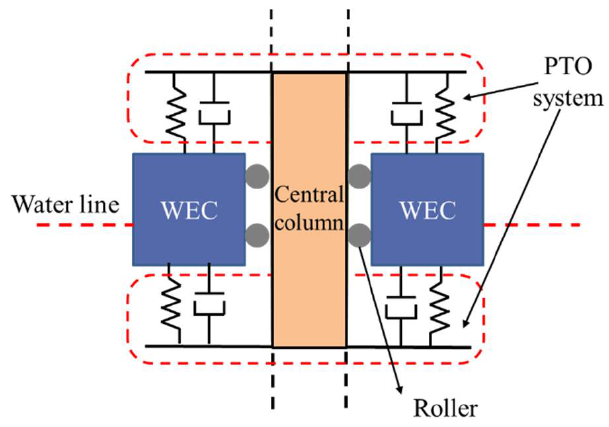
Figure 2. Simplified PTO system between platform and WEC.